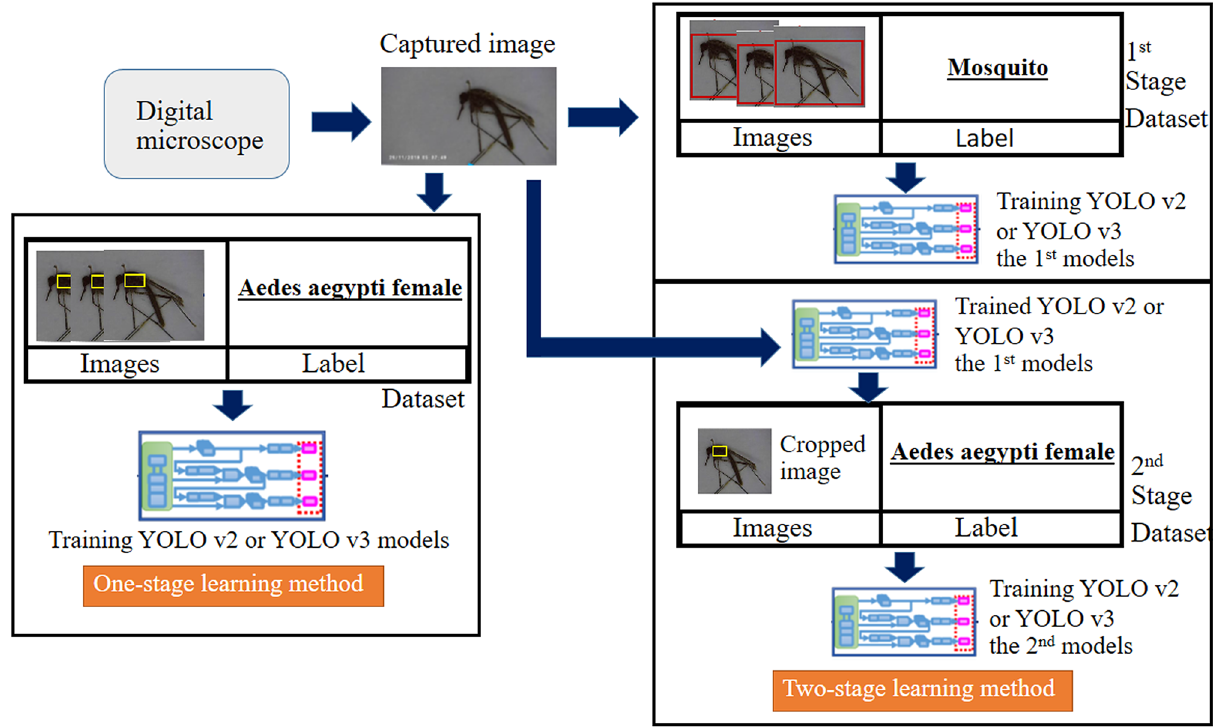
Figure 3. Workflow for data handling in the end-to-end neural network model, which consisted of two learning strategies, namely, the one-stage and two-stage learning methods. (1) The one-stage learning method progressed along the dark-blue dashed line, starting from the ground-truth labelling for the “genus, species and relative gender of the insect”. The ground truth labels, indicated in red rectangles, were trained in the [model] architecture. The output was displayed, pertaining to the correct relative genus, species and gender, in the output box or red rectangle, if the trained weight reached the optimal value. Under the CiRA CORE platform, the red rectangular box of the output could be selected to display or not display the value. (2) The two-stage learning method progressed along the light-blue dashed line. The start point corresponded to the ground-truth labelling for the mosquitoes and non-mosquitoes before performing the training using the [model_1] architecture, indicated in the red rectangle. The optimal trained weight was validated if could correctly distinguish between the non-mosquito and mosquito testing images. Later, the images in the set were cropped using one of the functions under the CiRA CORE programme, to be used as the dataset for the second learning process implemented using [Model_2] after labelling each cropped image pertaining to the relative genus, species and gender, as indicated in the yellow rectangle. The output could be displayed in two rectangular (red and yellow) boxes; the first box corresponded to the mosquito detection, and the second box corresponded to the classification of the relative genus, species and gender of the mosquito. Under the CiRA CORE platform, both the yellow and red rectangular boxes for the output could be selected to display or not display the